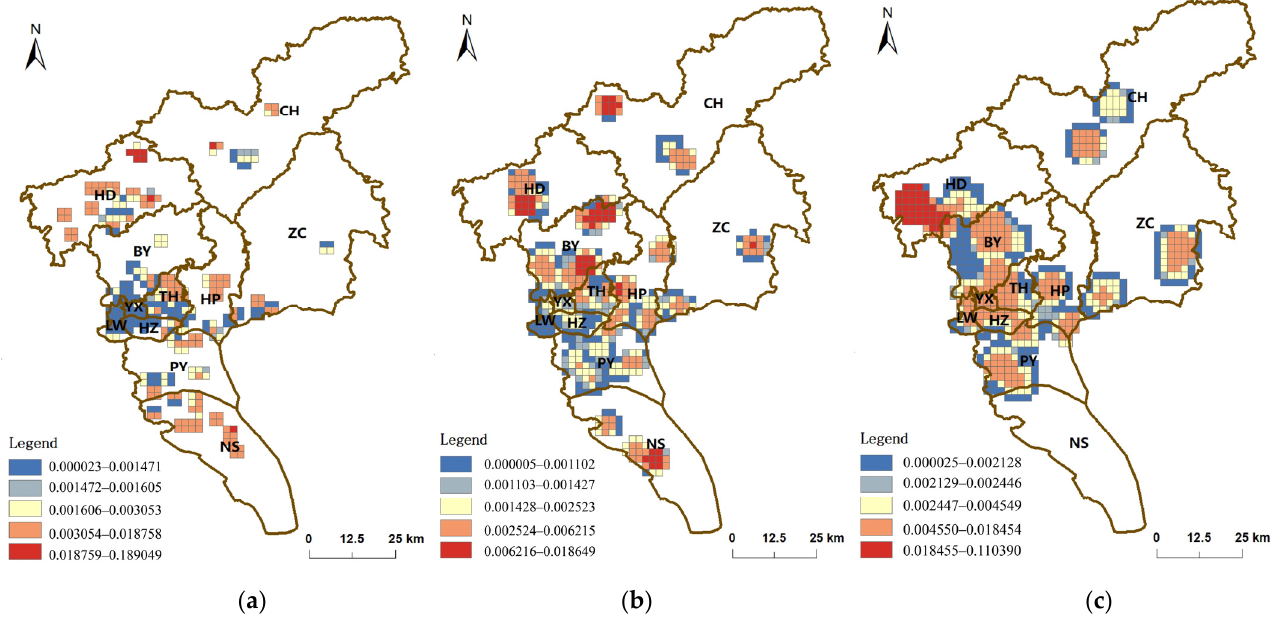
Figure 6. Evaluation of accessibility of tertiary medical institutions: ( a ) The accessibility of unclas- sified and primary hospitals; ( b ) The accessibility of secondary hospitals; ( c ) The accessibility of tertiary hospitals.